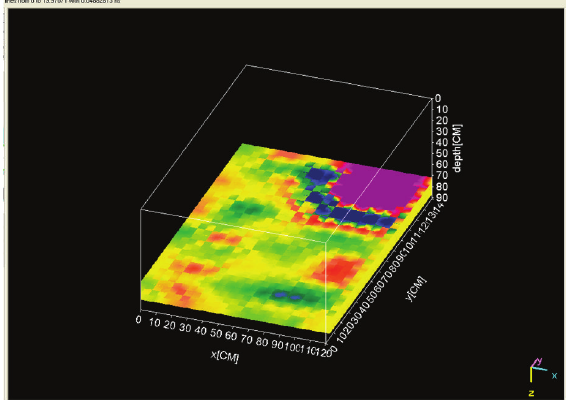
Figure 5: Constant depth slice at the depth of about 80 cm, achieved from migration.